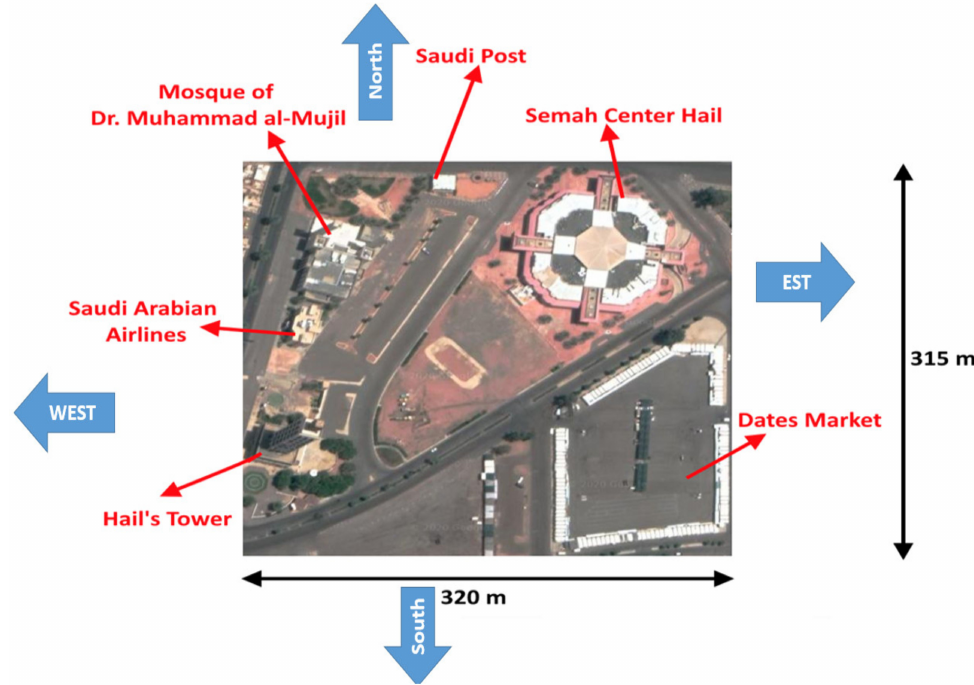
Figure 1. Real view of the studied